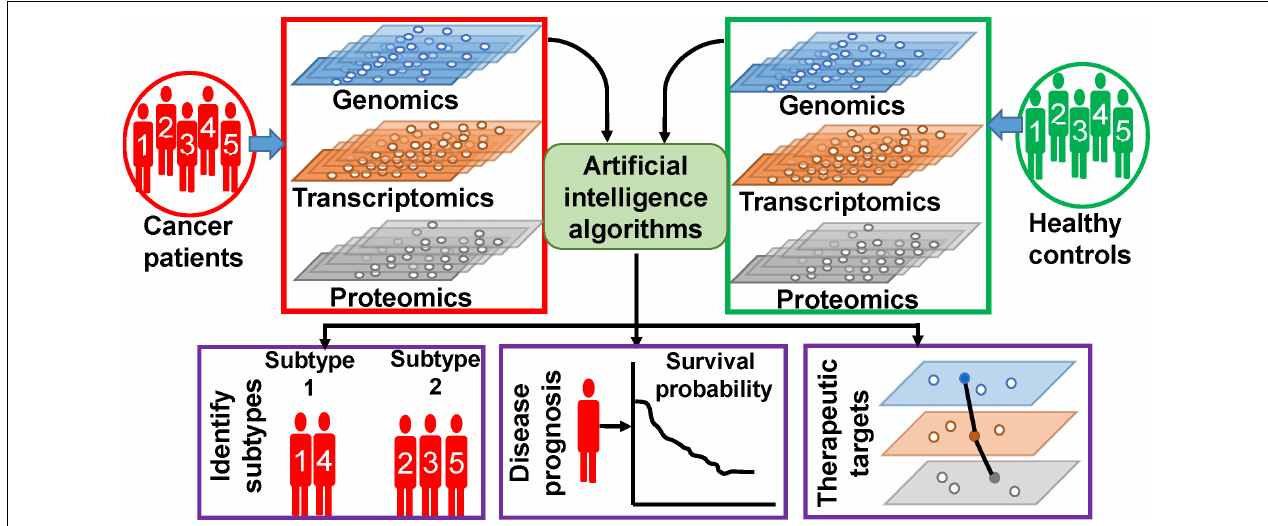
FIGURE 1 | Artificial intelligence (AI)-based analysis of multi-omics data. Different types of omics data are integrated and analyzed by AI algorithms to extract patient-specific